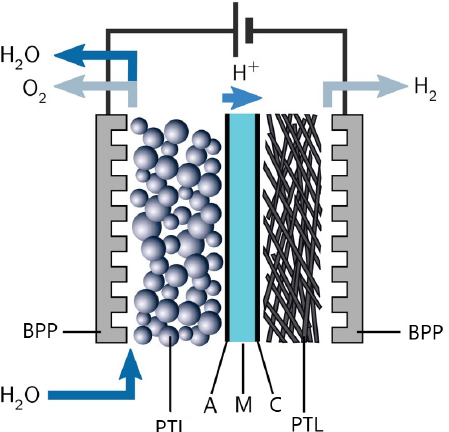
Figure 1. Proton-exchange membrane (PEM) cell consisting of the bipolar plates (BPPs), the porous transport layers (PTLs) on the anode and cathode side and the membrane electrode assembly (MEA), consisting of an anode (A), membrane (M) and cathode (C)